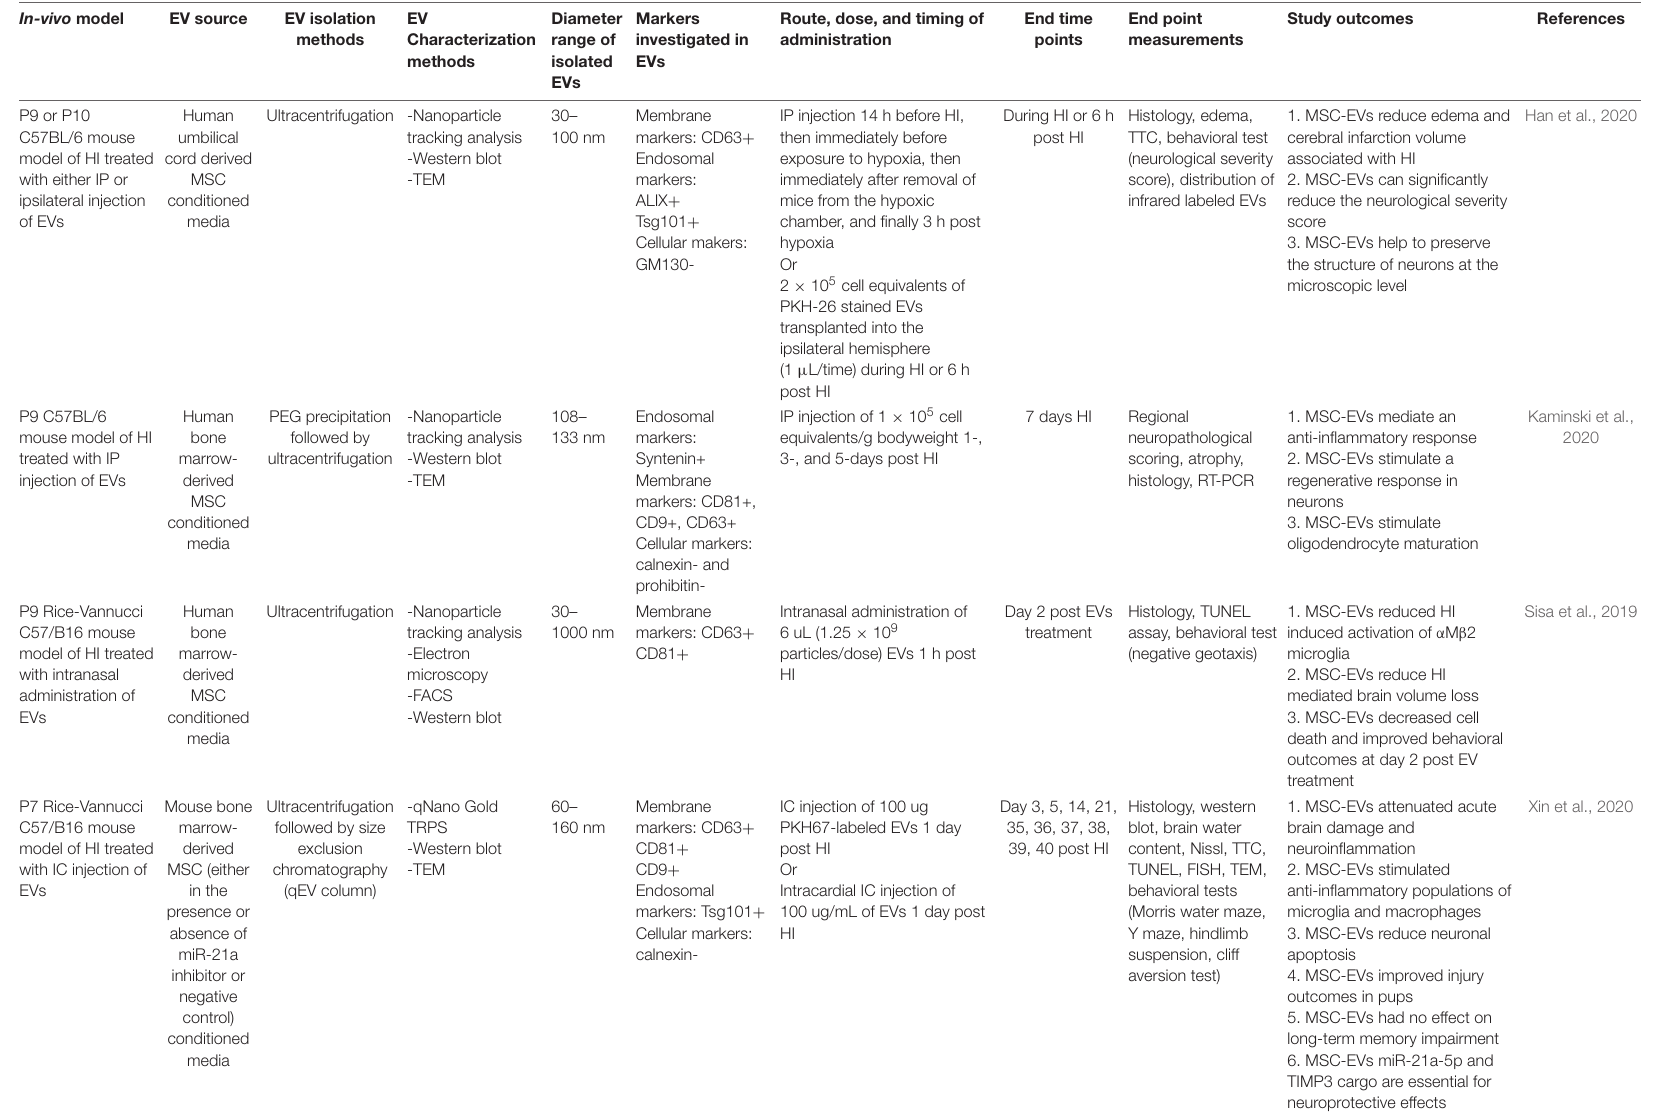
TABLE 1 | Investigations of the therapeutic potential of EVs in animal models of perinatal brain injury. In-vivo